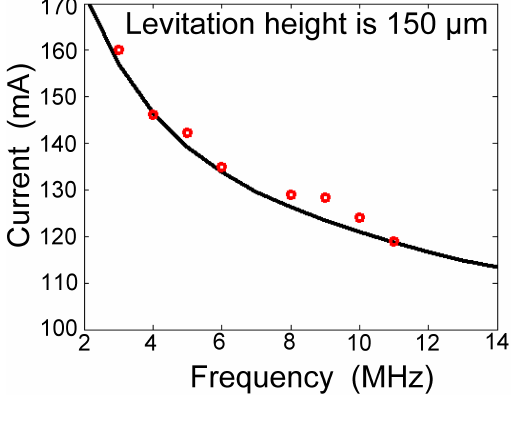
Figure 8. Current vs. frequency dependence for constant levitation